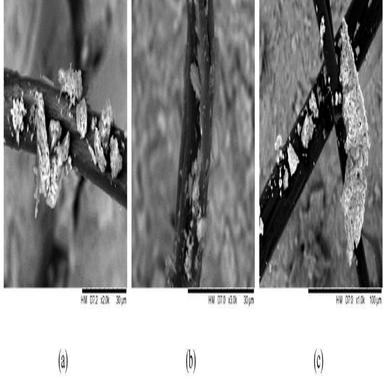
SEM micrograph (SE image) of hydration products precipitated on the PP fibers surface: (a) 0% CA, (b) 1% CA, and (c) 2% CA.